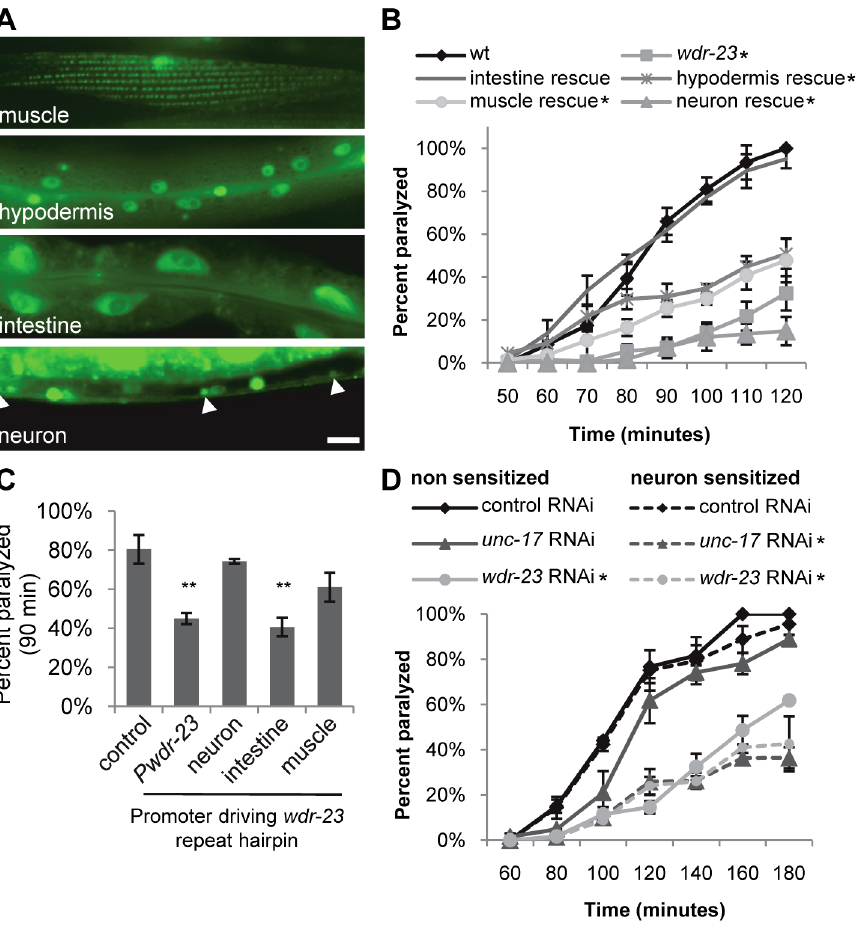
Figure 4. WDR-23 expression pattern and site of action. (A) Representative images showing fluorescence in the indicated tissues from transgenic animals expressing nuclear-localized gfp from the endogenous 1.3 kb wdr-23a promoter fragment. Arrowheads indicate neuronal cell bodies. (B–D) Paralysis on 1.0 mM aldicarb of the indicated strains. For rescue and knockdown, the following promoters were used: ges-1 (intestine), rab-3 (neuron), col-12 (hypodermis), and myo-3 (muscle). Intestinal and neuronal rescues were independently verified using nlp-40 and snb-1 promoters, respectively (data not shown). (B) Rates of paralysis of tissue-specific rescue of wdr-23 mutants. (C) Hairpin RNAi knockdown of wdr-23 in a sid-1(qt2) background results in tissue-specific aldicarb resistance after 90 minutes on aldicarb (Student’s t- test). wdr-23 indicates knockdown with endogenous wdr-23a promoter. (D) RNAi knockdown by feeding of the indicated genes in a wild type or neuronally sensitized ( nre-1 lin-15b ) strain. Control is the empty expression vector L4440. (Scale bar represents 10 m m; Error bars indicate 6 SEM. * p , 0.05, ** p ,